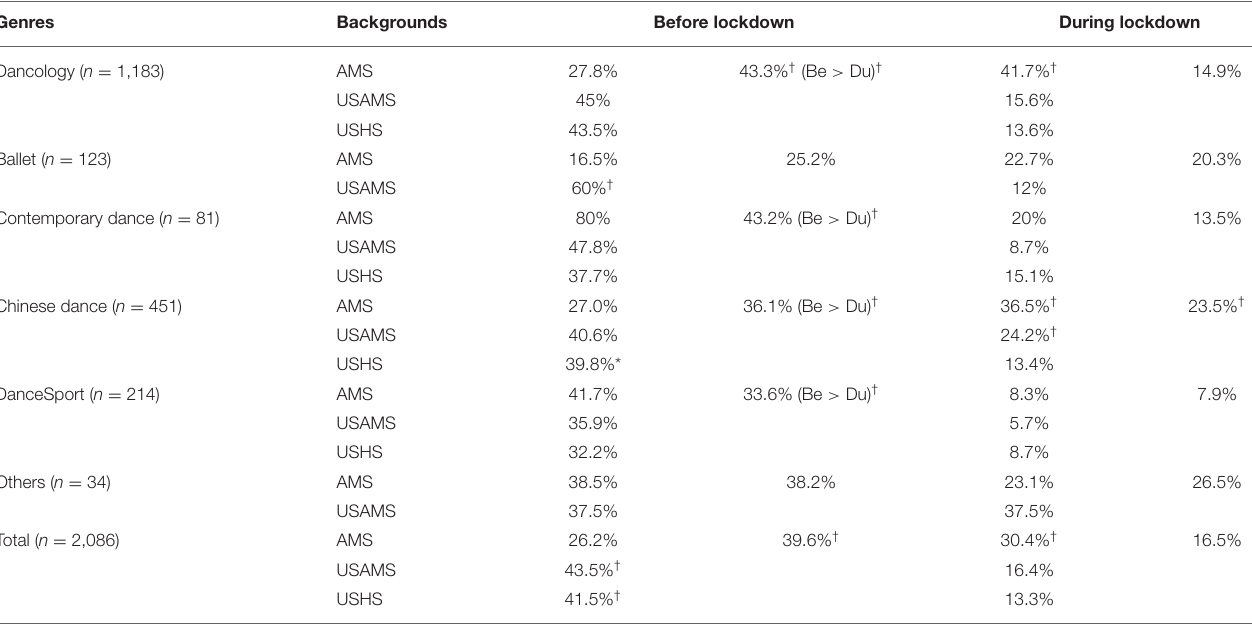
TABLE 2 | Dance injury prevalence in two different periods